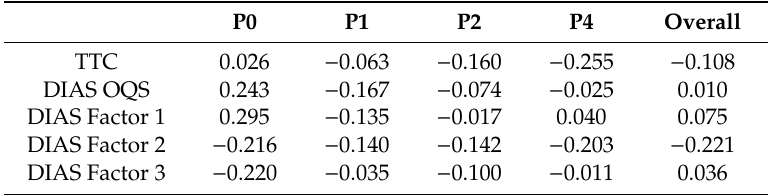
Table 5. Pearson’s correlations coe ffi cients between the percentage of choices of S + in the test phase, both at di ff erent S − distances (P0 = 350 cm, P1 = 310 cm, P2 = 270 cm, P4 = 190 cm) and across the whole test, and the number of trials needed to reach the learning criterion in the Training phase (TTC), the DIAS overall score (OQS), the score of the DIAS’ Factor 1, Factor 2 and Factor 3.